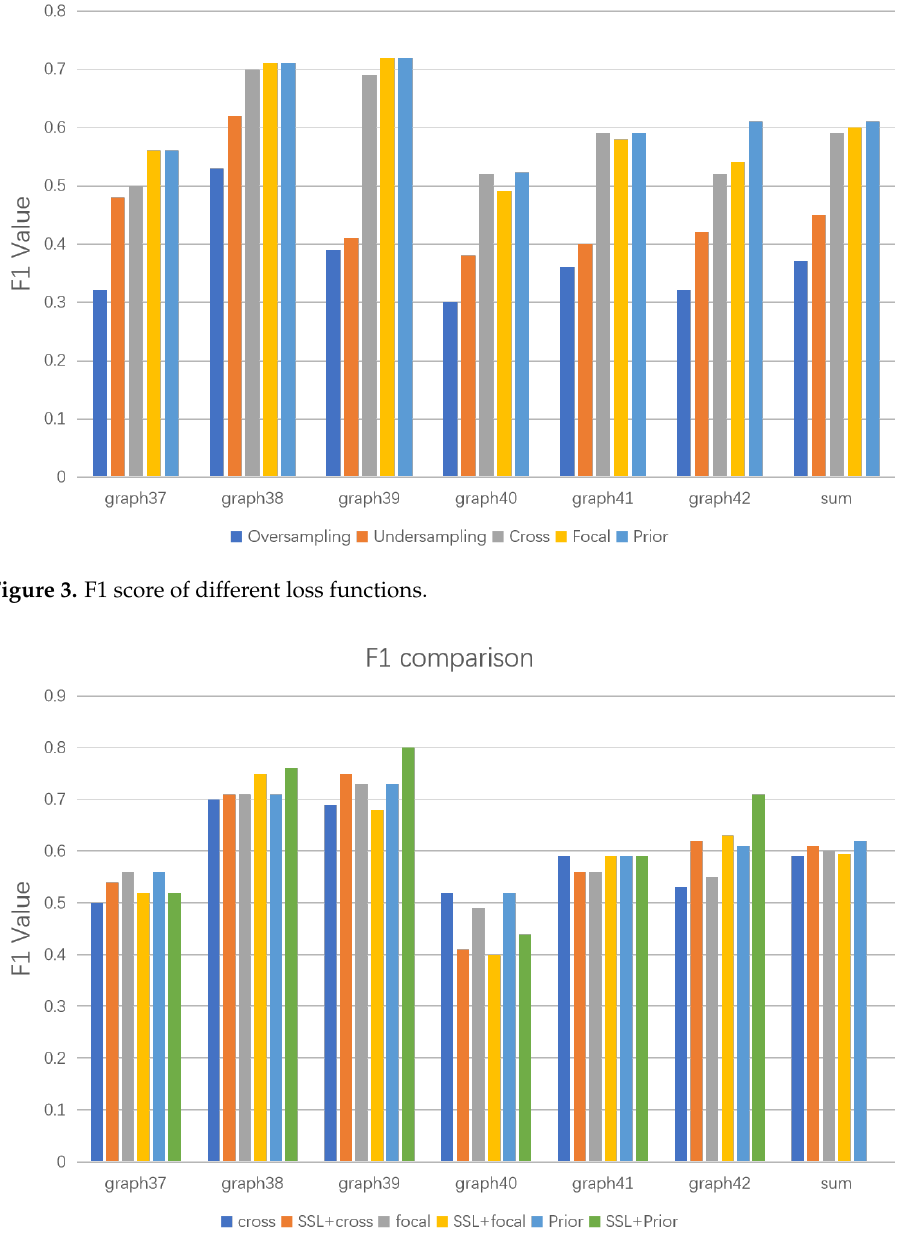
Figure 4. Experimental results after adding